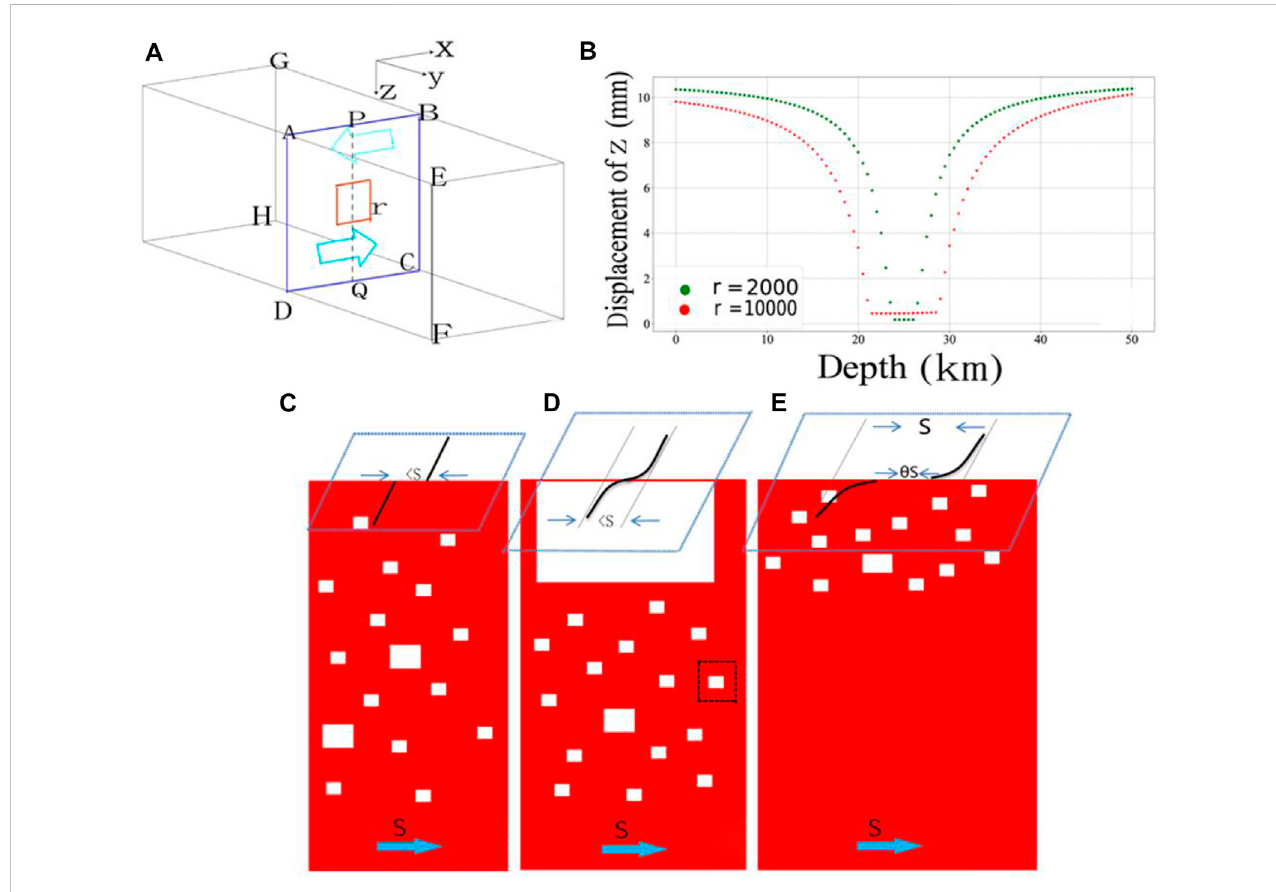
FIGURE 9 (A) Numerical simulation of the effect of asperity impediment using the three-dimensional (3D) numerical manifold method (NMM), which is useful for the simulation of discontinuous deformation as fault motion (Shi 2001; Wu et al., 2020). First, we set up a 3D research area and con fi ning pressure. Subsequently,wepushed(twobluearrows)inoppositedirections(AEFDinwardandBGHCoutward).Thered-linedboxrepresentsanasperity;thesidelength is r . Thedisplacement of thepushis 10 mm.A row of measuring points PQ line wasset up inABCD. (B) Vertical deformation ofthe measuring points; the deformationforasidelengthoftheasperityof2000misrepresentedbythegreendashedline;thedeformationforasidelengthoftheasperityof10,000 mis representedbythereddashedline. (C) S meansthefreesliprate.Smallandnumerousasperitieswithoutlargeasperities, < s meansthevalueofcreepingrateis smaller than the free slip rate S ; (D) small and numerous asperities in the lower part and a huge asperity on the top part of the fault; (E) small and numerous asperities on the top part of the